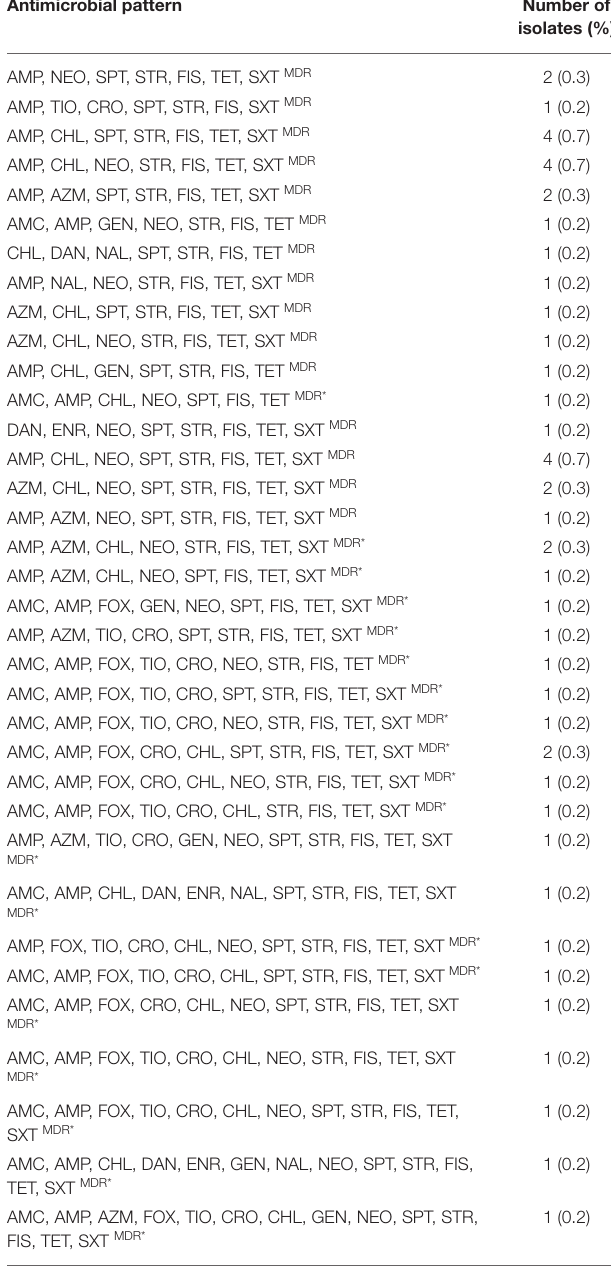
( Figure 6 ). The resistance gene bla CMY − 2 and a mutation in